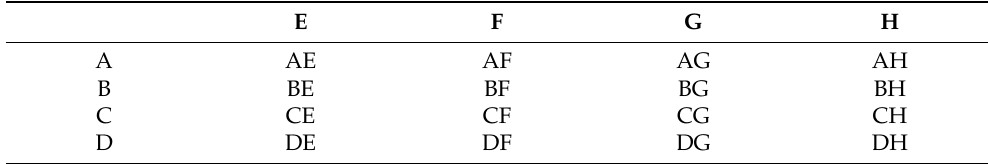
Table 1. The code of inbred lines and hybrids of Chinese